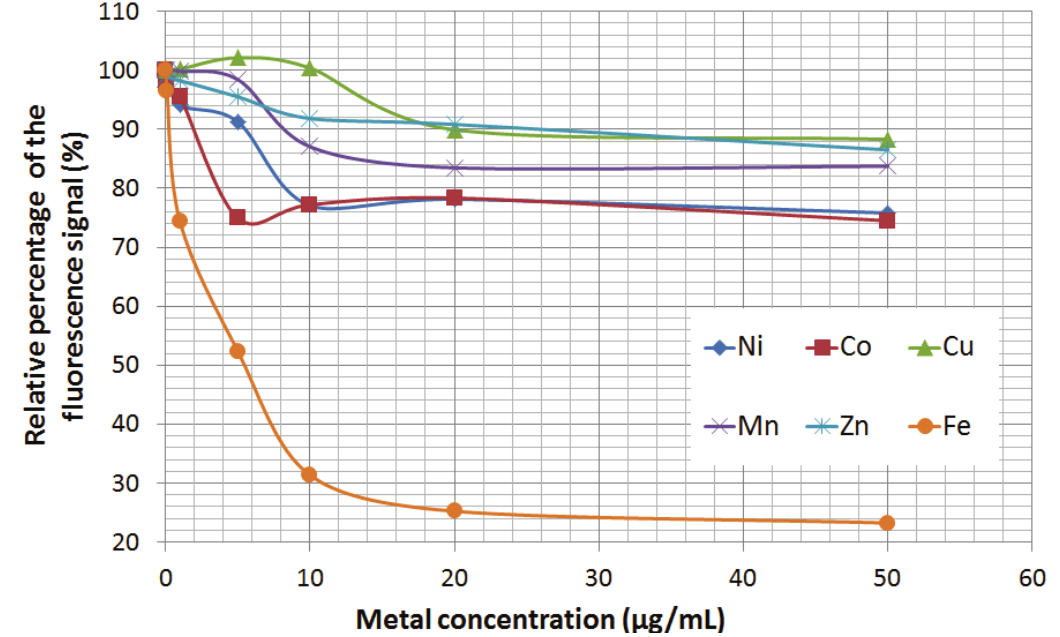
Figure 4 - Studies of the effect of potential interference of Ni, Co, Cu, Mn, Zn and Fe concentrations in the antimony atomic fluorescence